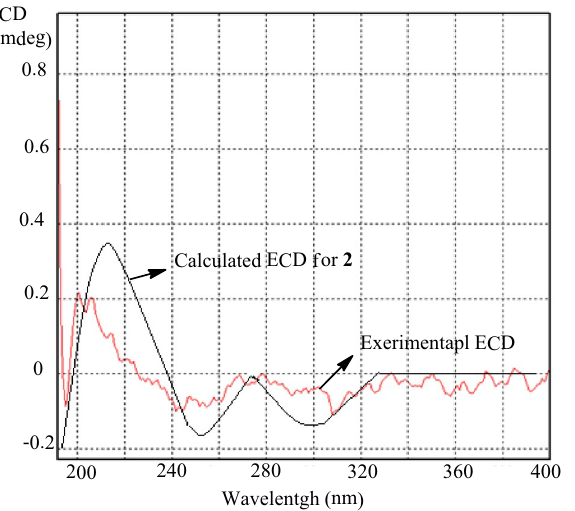
Fig. 3 Experimental and calculated ECD spectra for compound 2